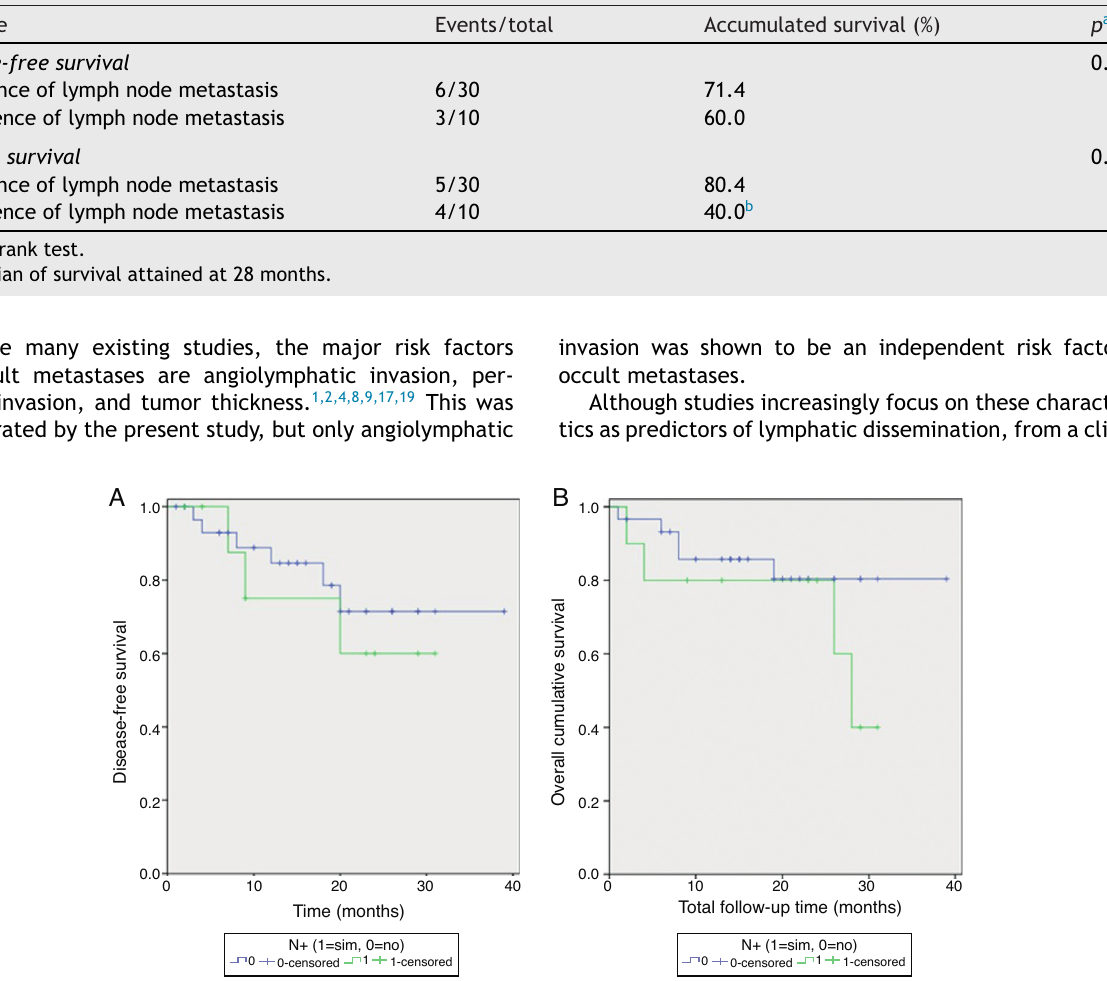
Figure 2 Kaplan---Meier curves comparing the groups with absence and presence of occult lymph node metastasis. (A) Cumulative disease-free survival of 71.4% and 60.0%, respectively, for the absence and presence of occult lymph node metastases ( p = 0.587 --- log-rank test); (B) Cumulative overall survival of 80.4% and 40.0%, respectively, for the absence and presence of occult lymph node metastases ( p = 0.248 --- log-rank